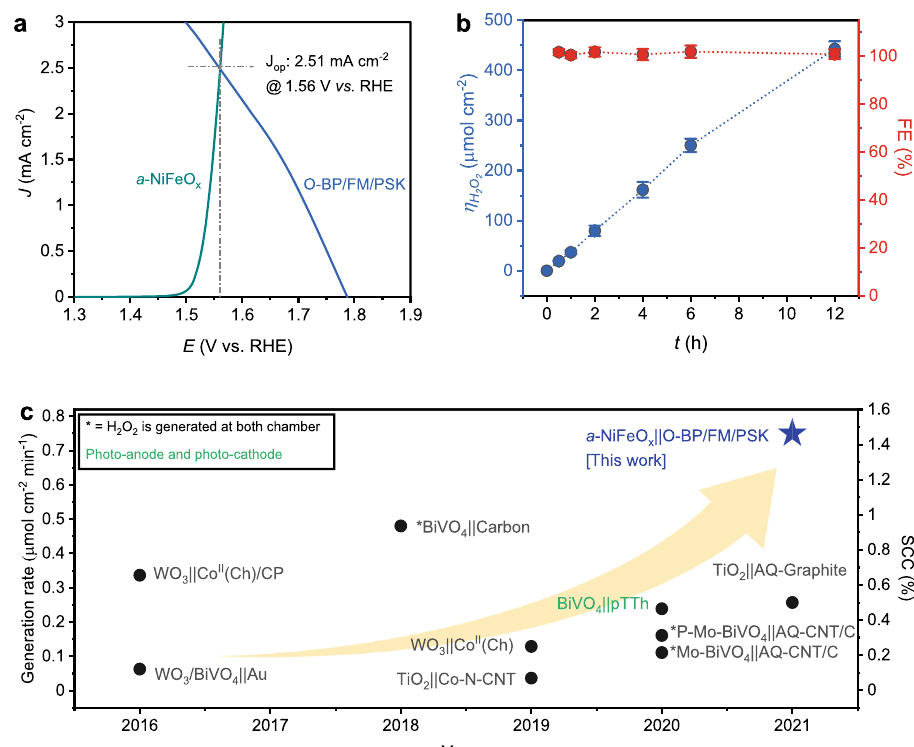
Fig. 4 Unassisted solar H 2 O 2 production with integrated photocathode system. a Operating point, obtained from the overlap of the a -NiFeO x /CP anode and the integrated system of the O-BP/FM/PSK photocathode, for the generated solar H 2 O 2 affords a photocurrent of ~2.51 mA cm − 2 for generating solar H 2 O 2 in the catholyte. b In a two-electrode set-up under simulated 1-sun conditions, the unassisted H 2 O 2 production ( n ) of our integrated O-BP/FM/PSK device could continuously produce ~442 ± 15.2 μ mol cm − 2 of H 2 O 2 for 12 h, without any degradation, at 0 V. Here, the error bars indicate the standard deviation based on averaged data of fi ve integrated devices illustrating n H2O2 and FE (%). c Graph showing the generated rate of solar H 2 O 2 on the left y -axis, while the corresponding solar-to-chemical conversion ef fi ciency (SCC;%) has been marked on the right y -axis (Supplementary Table 2). The highest SCC ef fi ciency peaked after 2 h of reaction, also demonstrated in Supplementary Fig.